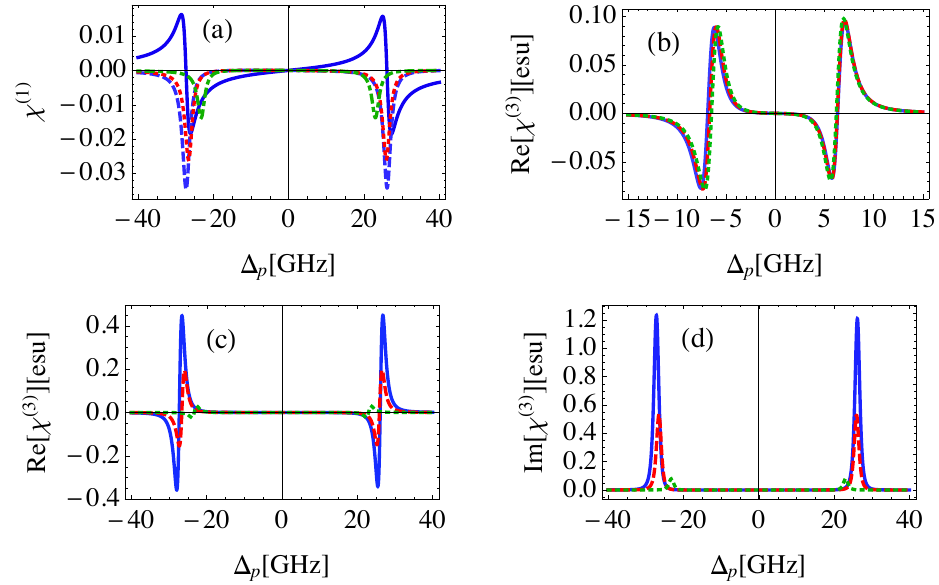
Figure 2. ( a ): The real (solid) and imaginary (dashed,dotted,dashed-dotted) parts of the linear susceptibility for the MNP-GND-QD hybrid system of R GM = 23 nm, θ G = 1 rad, θ M = 0.4 rad (solid,dashed), θ M = 0.45 rad (dotted), θ M = 0.5 rad (dashed-dotted). ( b ): The real part of the third order nonlinear susceptibility for the system of R GM = 27 nm, θ G = 1 rad, θ M = 0.4 rad (solid), θ M = 0.45 rad (dashed), θ M = 0.5 rad (dotted). ( c , d ): The real ( c ) and imaginary ( d ) parts of the third order nonlinear susceptibility for the system of R GM = 23 nm, with the same values of θ G and θ M presented in ( b ). The system is excited with resonant control field of Ω c = 50